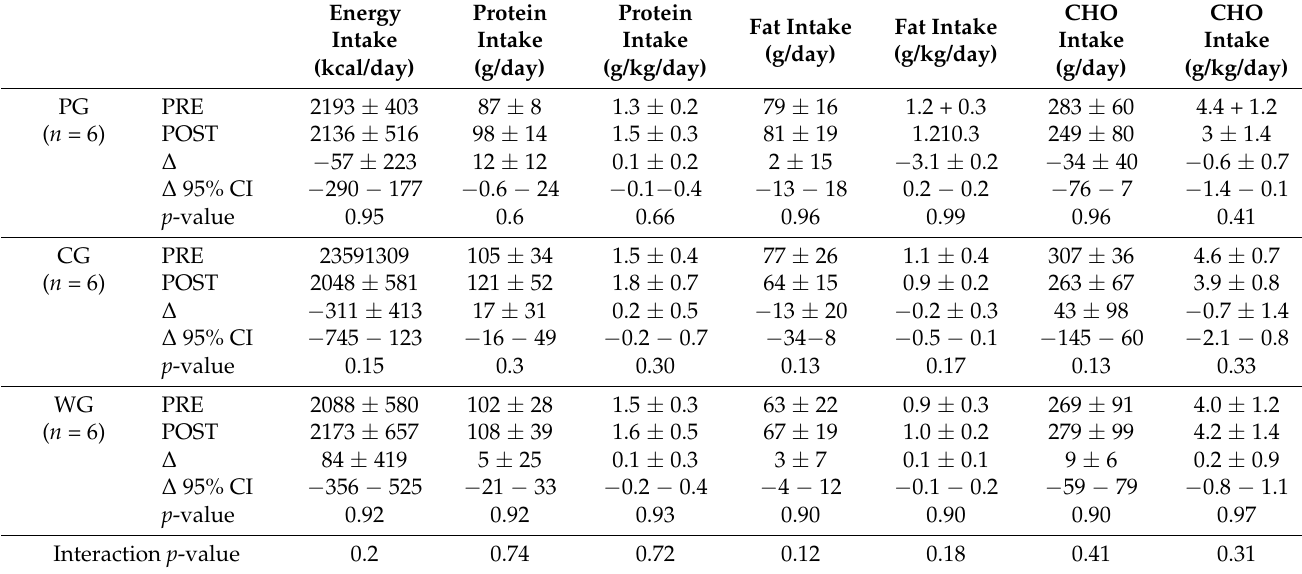
Table 2. Dietary energy and macronutrient intake before (PRE) and after (POST) an eight-week resistance training program in the placebo (PG), chia flour (CG) and whey protein (WG) group.